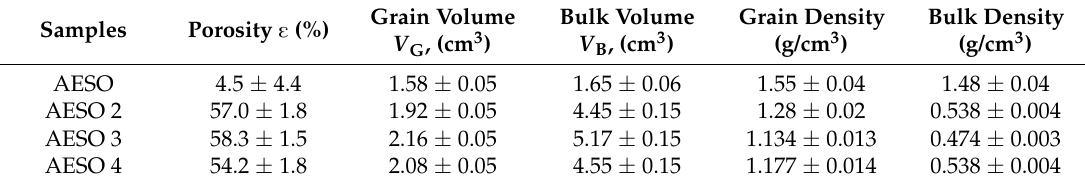
Table 1. The porosity, volumes and density of the pristine AESO and cellulose-reinforced AESO foams.